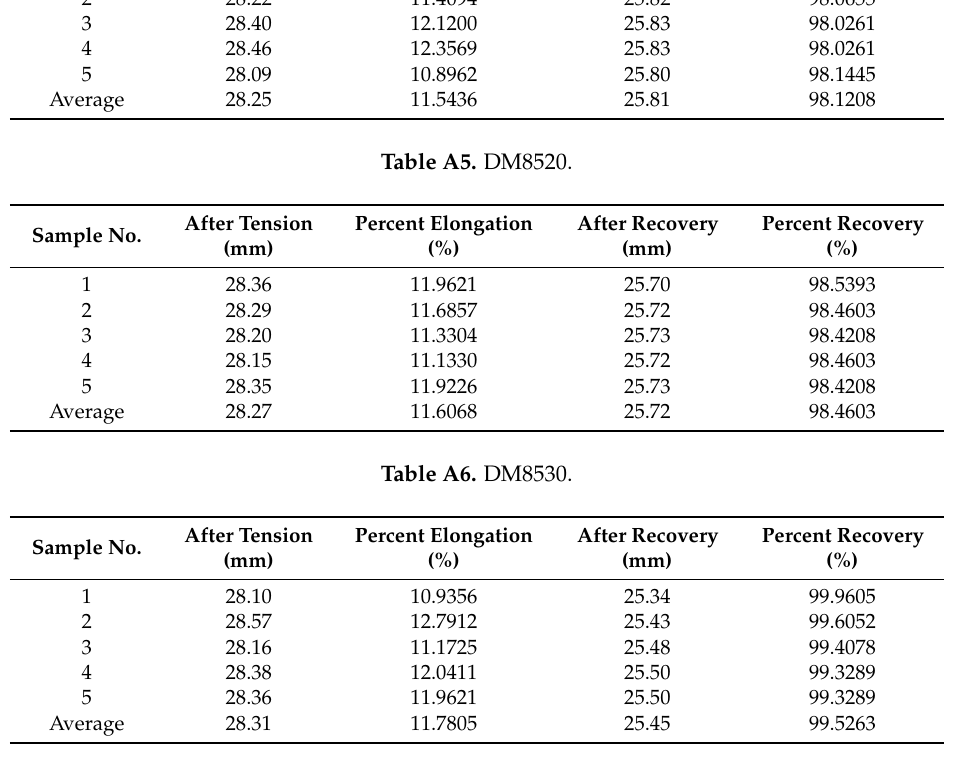
Table A7. Glass transition temperatures of four materials used in the present research